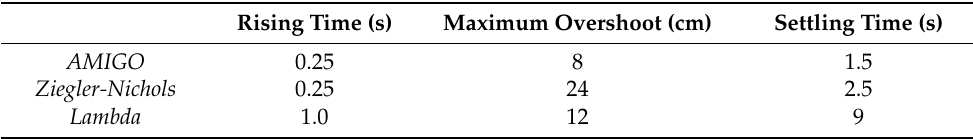
Table 8. The rising time, maximum overshoot and settling time for the step response without any additional